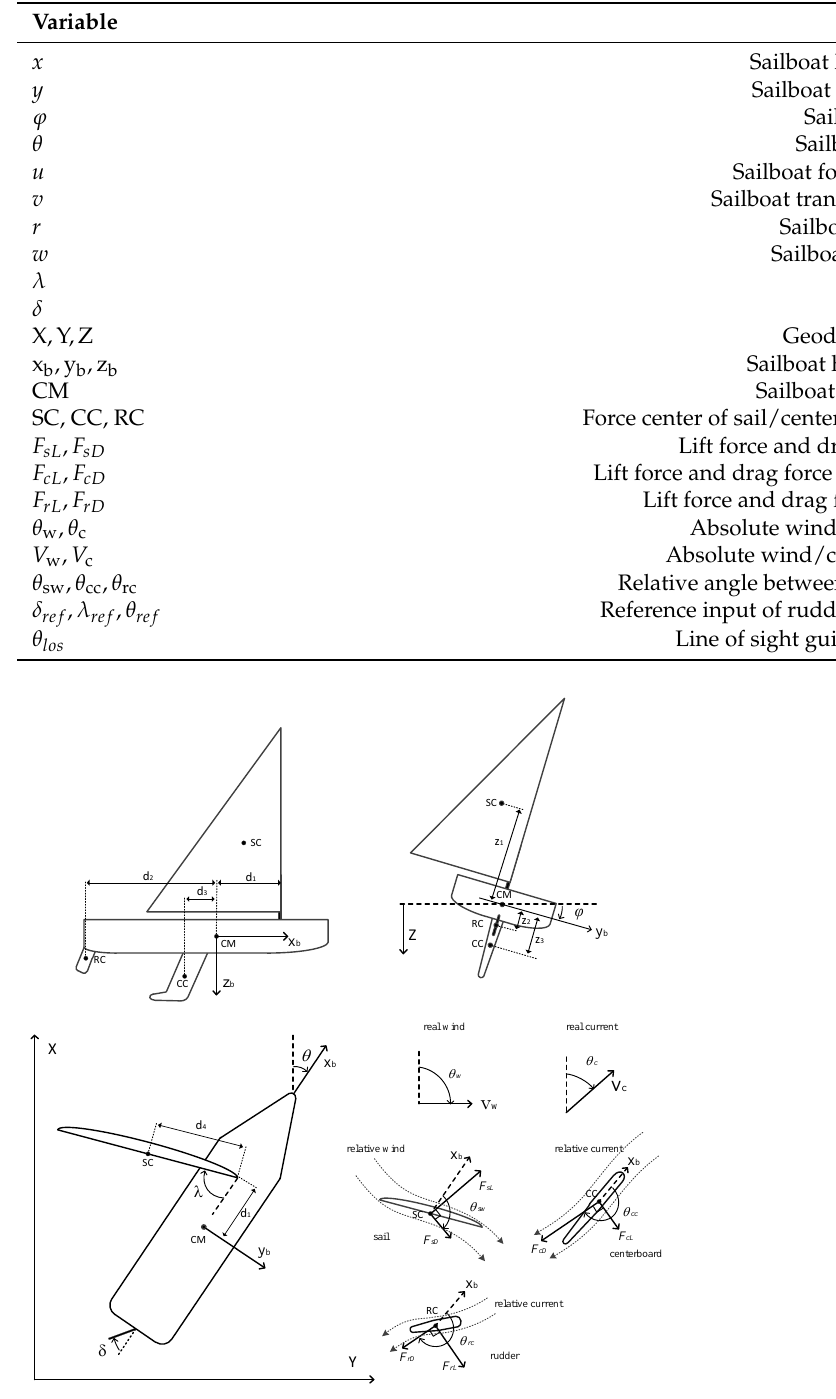
Figure 1. Variables and schematics of sailboat